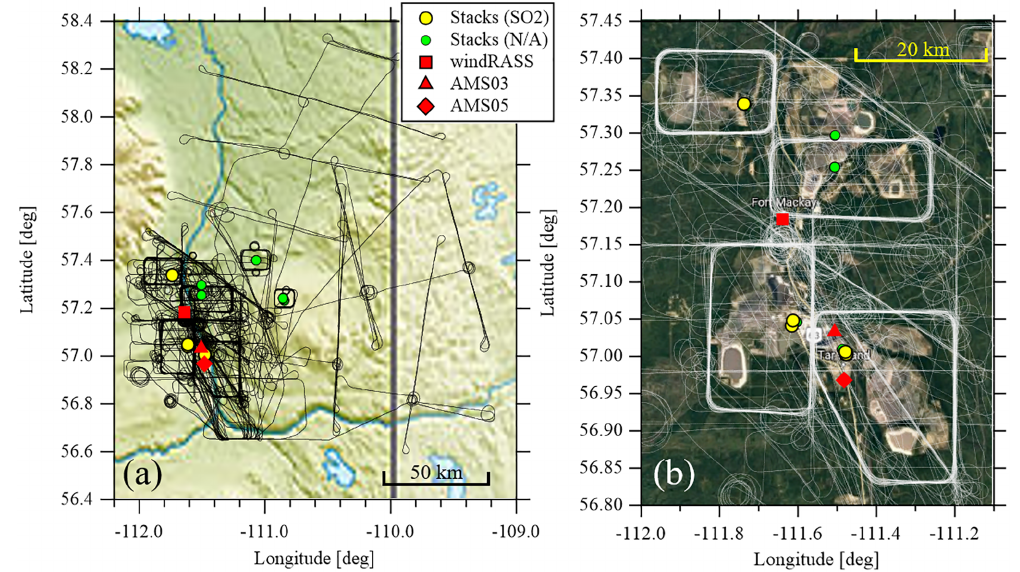
Figure 1. The flight tracks (black lines in a , white lines in b ) during the 22 flights of the JOSM study, compared to the location of the following: the facility stacks, including SO 2 emitting stacks used for this analysis (yellow circles) and non-SO 2 emitting stacks (green circles); the radio-acoustic profiler (windRASS, red square); and the WBEA meteorological towers, AMS03 (red triangle) and AMS05 (red diamond). Stack towers in close proximity are overlapping. The relief map (a) shows the extent of the flight area and the Athabasca river ◦ valley with the Alberta–Saskatchewan border shown at − 110 longitude (Wikipedia, credit: Carport). The satellite image (b) is a close-up in the region of the facilities (Google: Landsat/Copernicus,